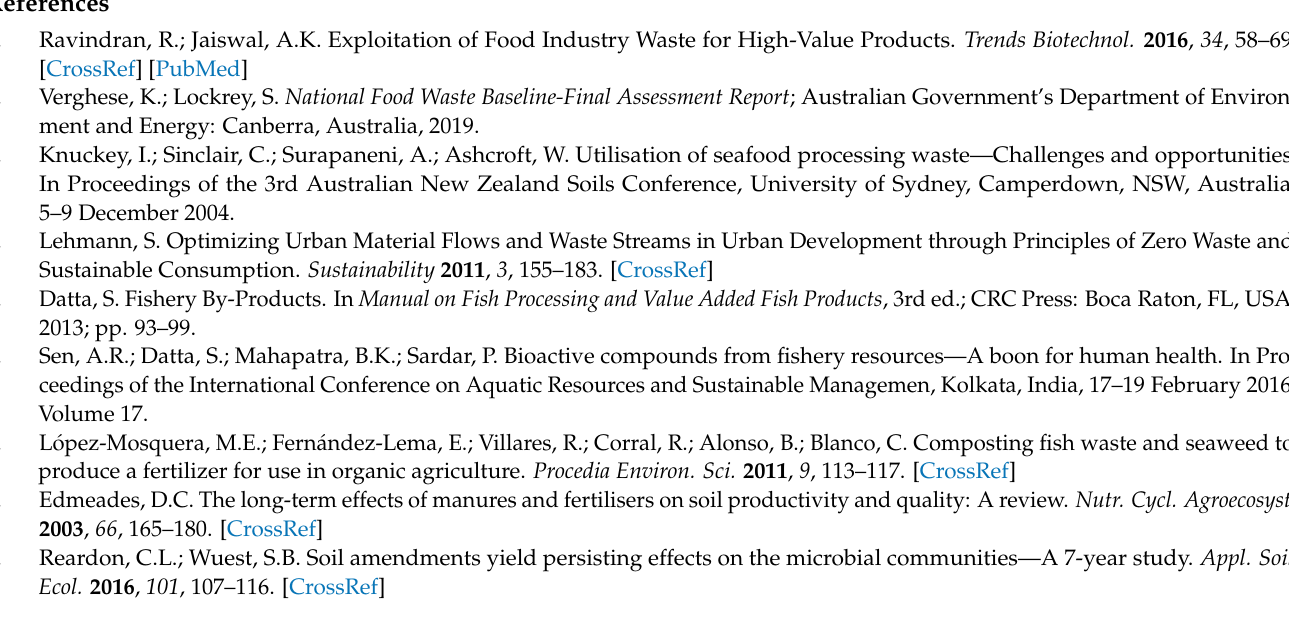
Table S2: Two-way Anova with repeated measure of weekly tomato plant growth parameters. Table S3: Permanova analysis of proportion of leaf nutrient content for UWP treatments (T1–T7) and the Hoagland’s control. Table S4: Two-way Anova with repeated measure of weekly tomato plant measurement of flower and fruit production. Table S5: Average fruits dry matter content (%), fruits loculi number and fruit pericarp thickness of tomato plants in greenhouse pot trial under UWP treatments (T1–T7) and Hoagland’s control (T8). Table S6: Permanova analysis of proportion of fruit nutrient content for UWP treatments (T1–T7) and Hoagland control (T8). Table S7: Permanova analysis of fruit ripeness parameters (colour coordinates and firmness) and quality attributes (pH, TA and SSC) for UWP and treatments (T1–T7) and Hoagland control (T8). Figure S1: On the left tomato plant treatments randomly arranged on benches inside the greenhouse (left to right T6, T8, T6, T2, T4). On the right close up of leaf